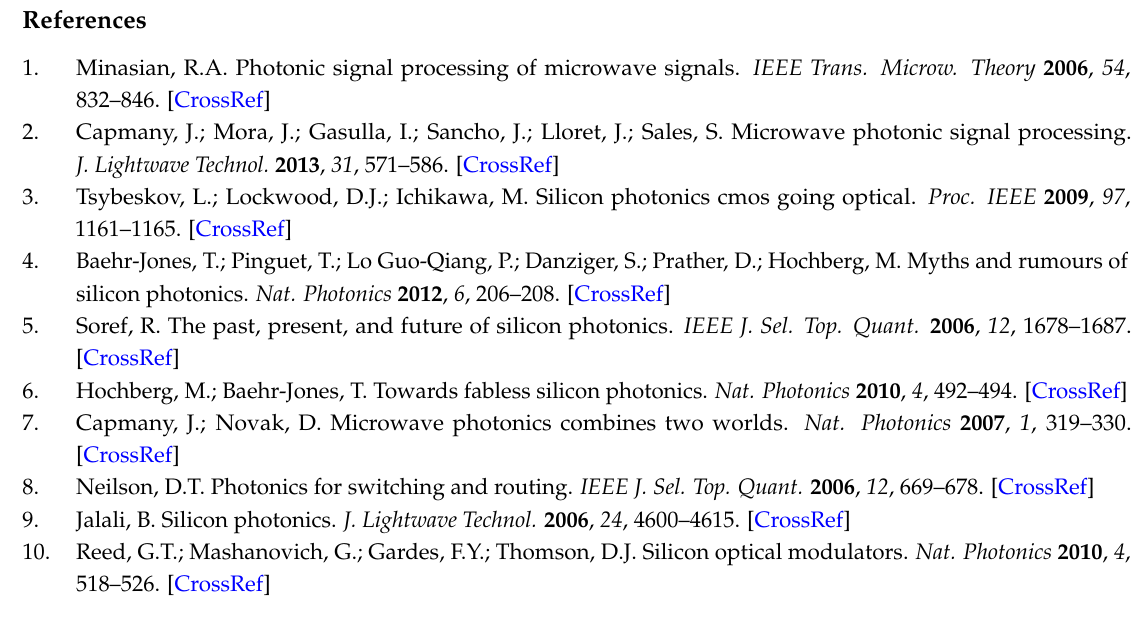
Configurations & Actuation